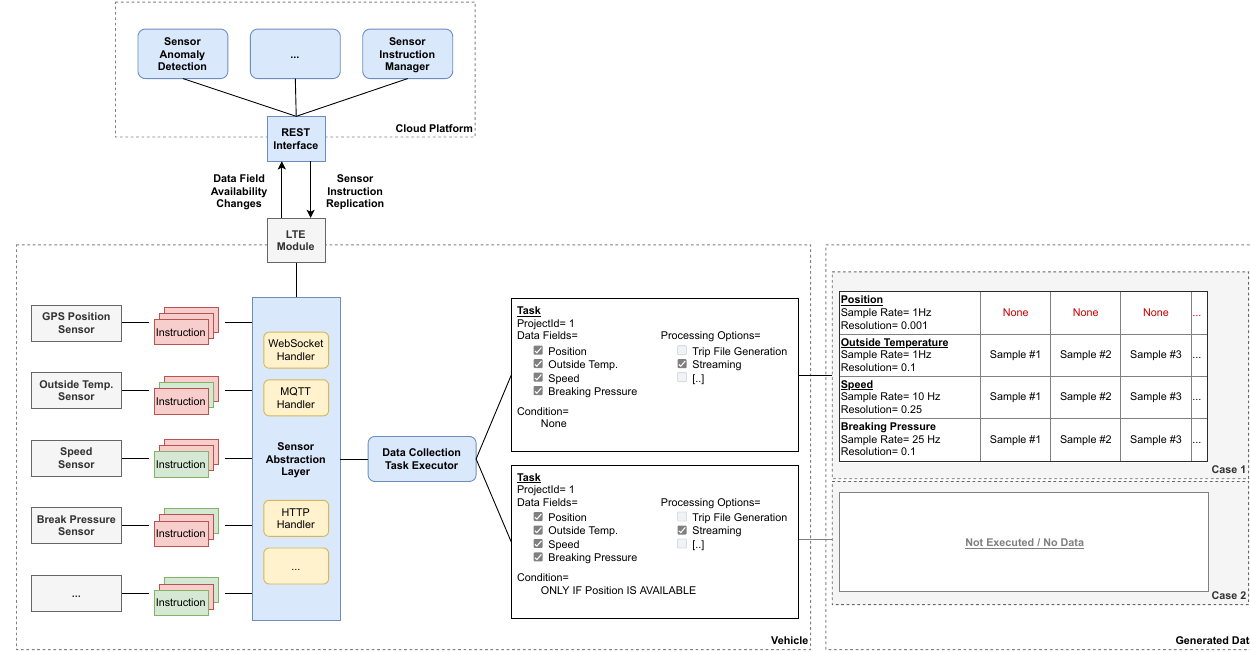
Figure 3. Usage of the sensor abstraction layer. Individual instructions are available for each sensor. Instructions that are compatible with the specific vehicle are marked in green, and incompatible instructions are marked in red. In the first case, as much data as possible is collected, resulting in a sparse dataset because a data field is not available. In the second case, no sensor readings are collected at all because the condition does not